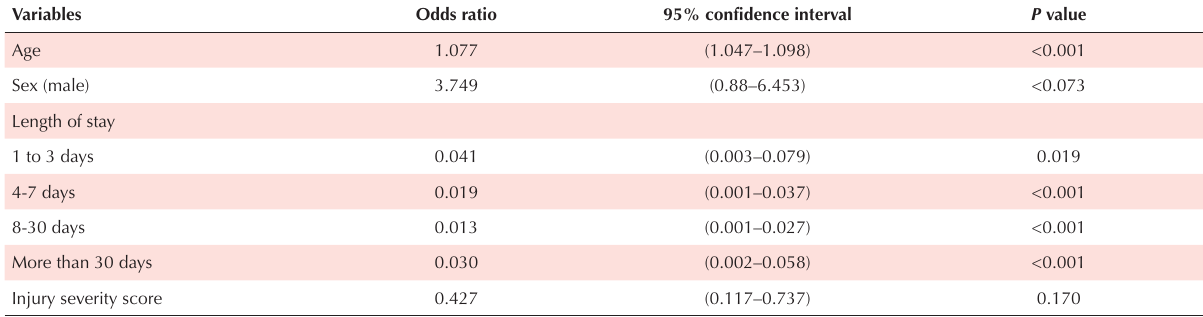
Table 3 . Logistic regression coefficients and odds ratios of the variables of mortality between trauma patients